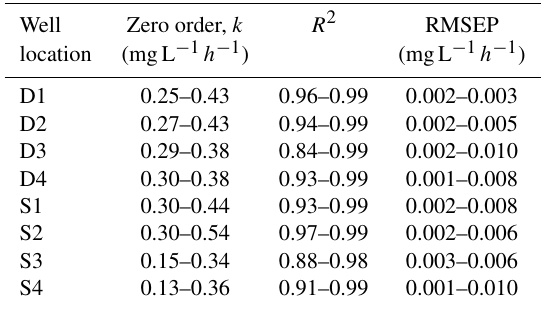
Table 3. Zero-order NO − removal rates, k , at eight well locations 3 during five experimental trials. The zero-order kinetics model was fitted to time series of NO − concentrations after flow to the lab 3 bioreactor was stopped. RMSEP refers to the root mean square error of